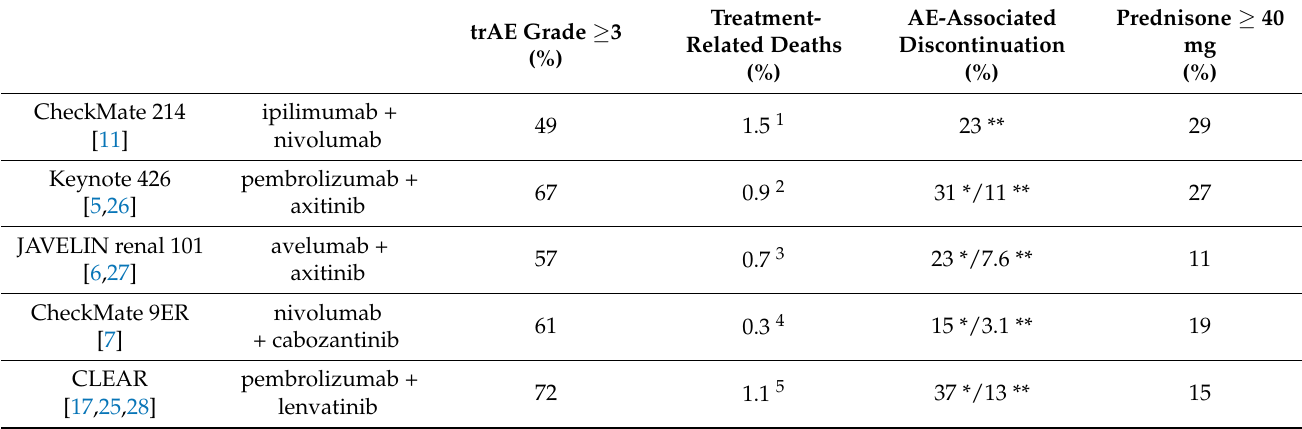
Table 2. Rate of serious adverse events with PD-(L)1-ICI-based combination therapies. (tr)AE, (treatment-related) adverse